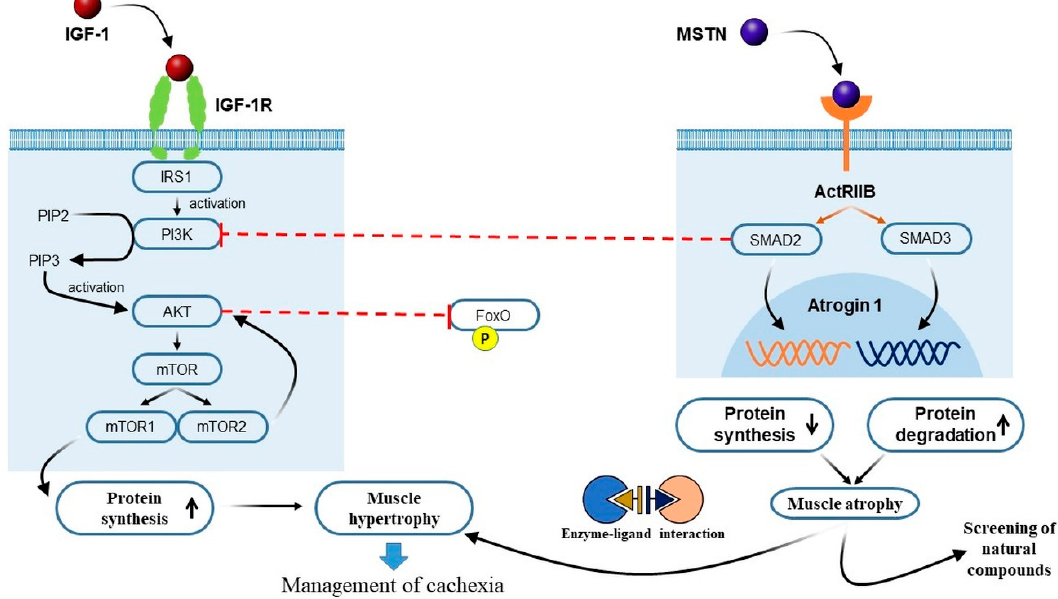
Figure 2. Molecular mechanisms regulated by IGF-1 and MSTN: Active Akt produces the mTOR signal, which leads to protein synthesis and inhibits (phosphorylates) FoxO. IGF-1 is primarily responsible for protein synthesis and muscle hypertrophy, whereas MSTN is responsible for protein degradation causing muscle atrophy. We suggest that screening of natural compounds and their derivatives for anti-MSTN activity might shift the balance toward muscle hypertrophy in cachexia.